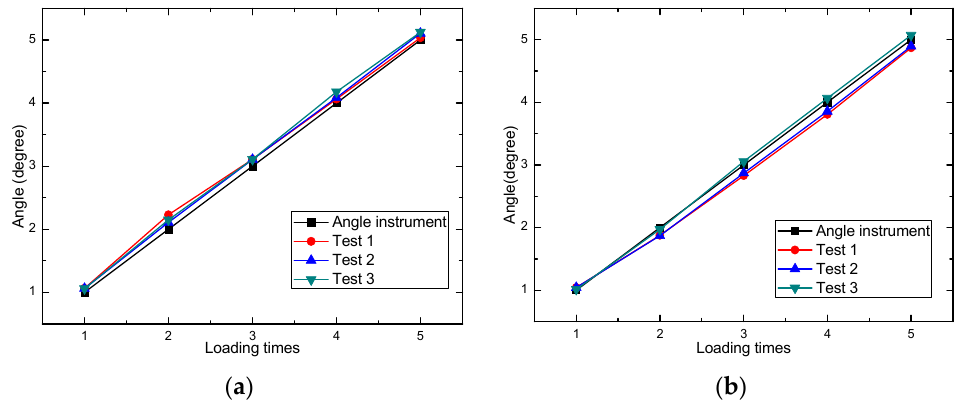
Figure 7. Angle step comparison between smart phone and angle instrument. ( a ) Angle step around x -axis; ( b ) Angle step around y -axis